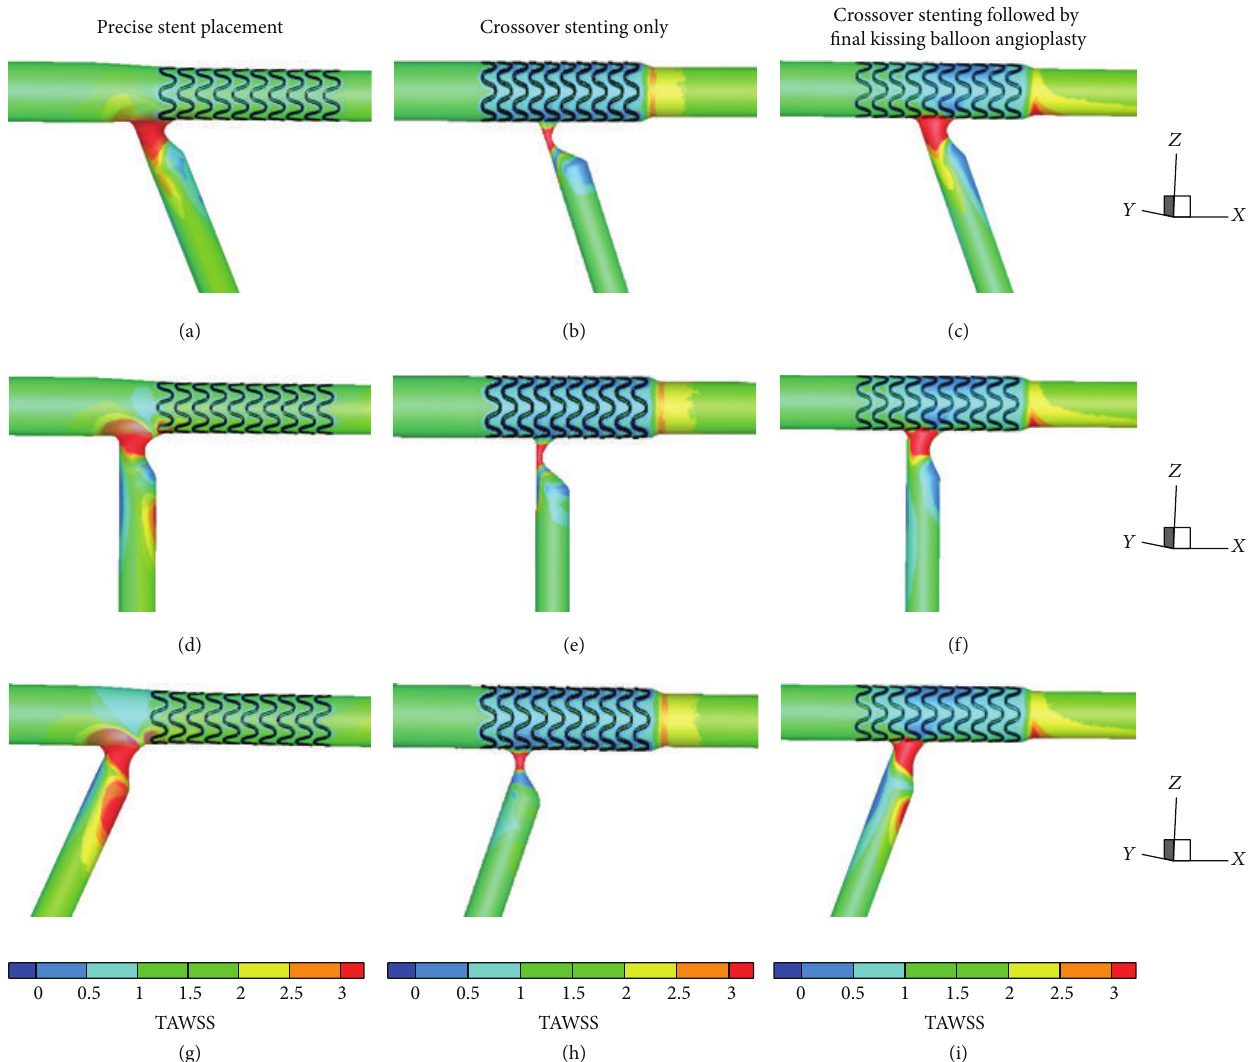
Figure3:Time-averagedwallshearstress(TAWSS)distributionatthebifurcationfortheconsideredthreestentingtechniquesunderdifferent bifurcation angle conditions. (a), (b), and (c) illustrate stenting techniques under 70 ∘ bifurcation angle condition; (d), (e), and (f) under 90 ∘ bifurcation angle condition; (g), (h), and (i) under 110 ∘ bifurcation angle